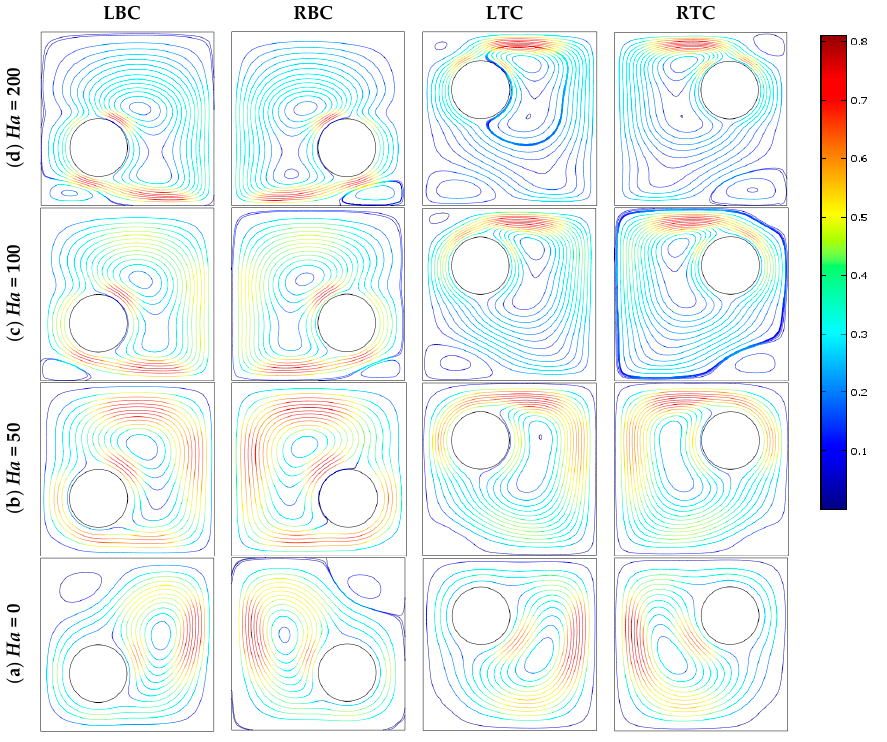
Figure 7. Streamlines for different orientations of heated cylinders for Ha = 0–200, Ra = 10 5 and Pr = 0.71 .